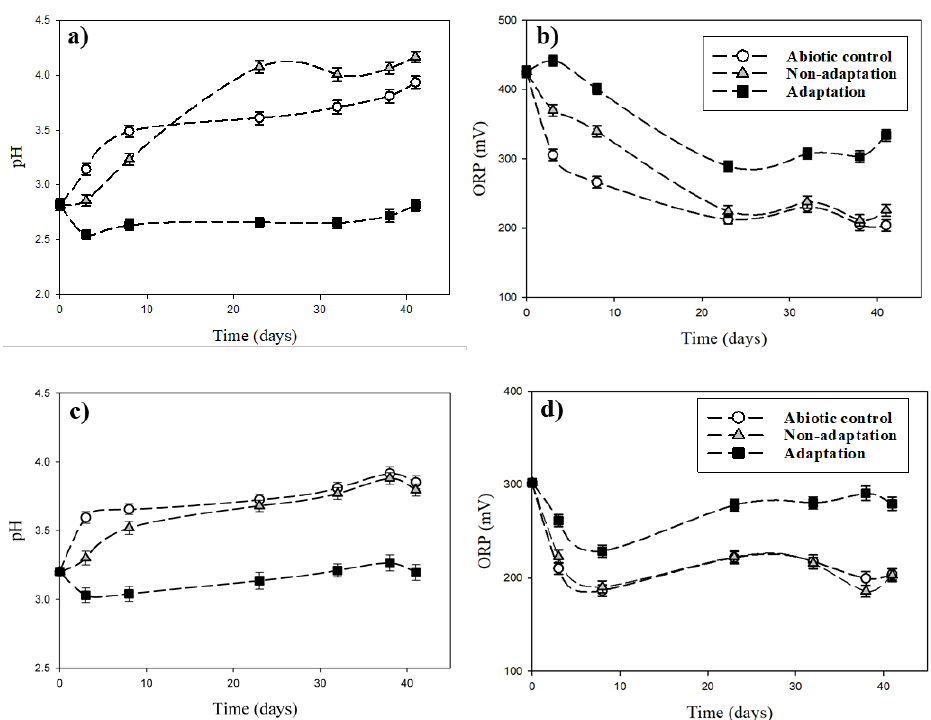
Figure 6. Variations of pH and ORP during bioleaching of the pyrrhotite under different initial pH conditions: ( a ) and ( b ), pH ini. 2.8; ( c ) and ( d ) pH ini. 3.2.